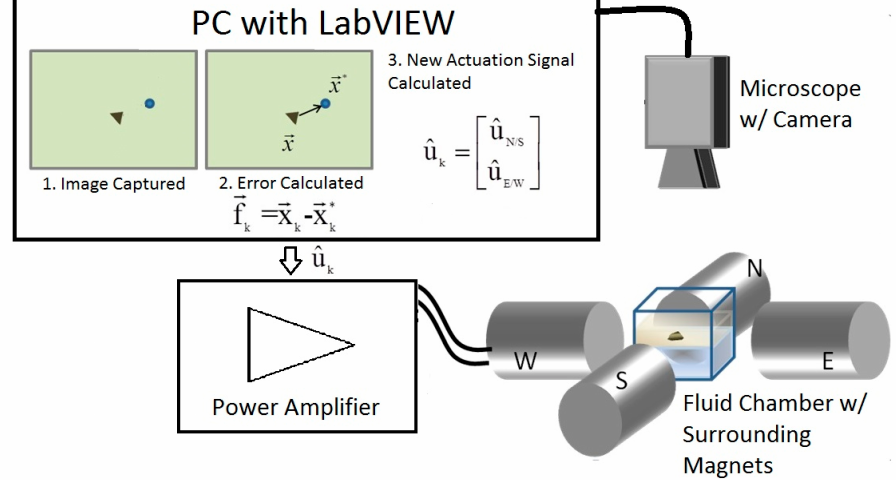
Figure 2. As the microrobot moves, the position error f k between the target and the robot are monitored in the k th image. The actuation signal u k is a duty cycle for a square wave sent to each electromagnet pair at the k th iteration of the control